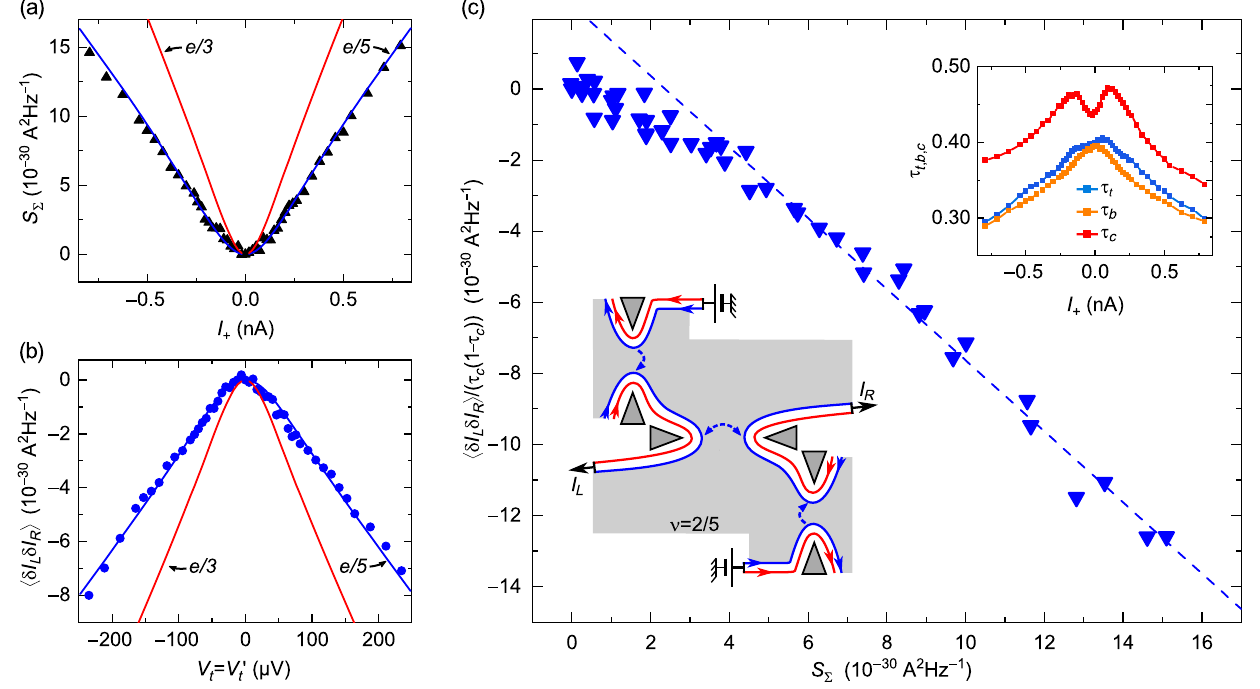
FIG. 7. Cross-correlation signature of anyons in the inner edge channel at ν ¼ 2 = 5 . The sources are symmetrically voltage biased 0 ) except for the separate analyzer characterization in (b), where V 0 ) implements a direct voltage bias. V V 0 ( V , V 0 ( V t ¼ t t ¼ b t ¼ b ¼ (a),(b) Shot noise characterization of the charges e emitted from the sources (a) and of the tunneling charge e across the analyzer (b). t;b c The shot noise data (symbols) are compared with the predictions for e (cid:2) ¼ e= 5 (blue lines) and e= 3 (red lines). (c) Experimental determination of P . The normalized cross-correlation data, from which the estimated interchannel tunneling contribution (see Appendix D) is removed, are plotted as symbols as a function of the same S Σ also shown in (a). P ≃ − 1 . 0 is obtained from a linear fit of the slope (blue dashed line). Inset: simultaneous measurements of τ t;b;c